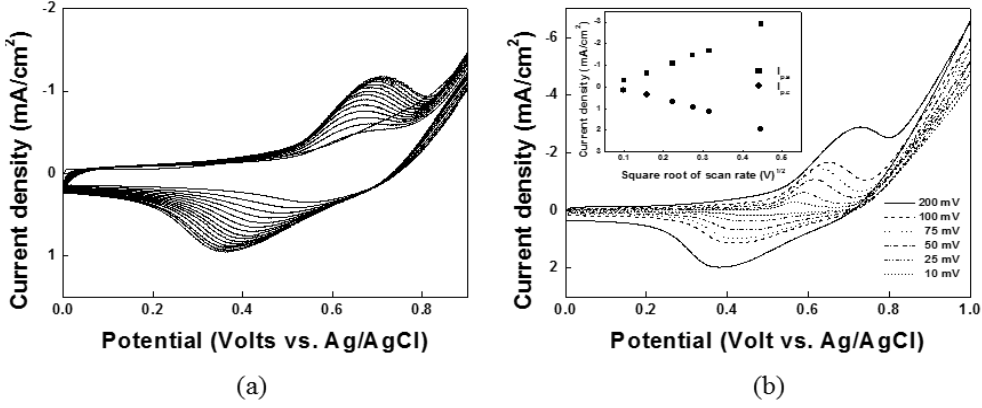
Figure 1. Cyclic Voltammograms for ( a ) electrodeposited Ni(OH) 2 /NiOOH on the DSPNCE and ( b ) at various scan rates from 10–200 mV/s; Inset of ( b ) was plotted by the anodic and cathodic peak currents vs. scan rate 1/2 .